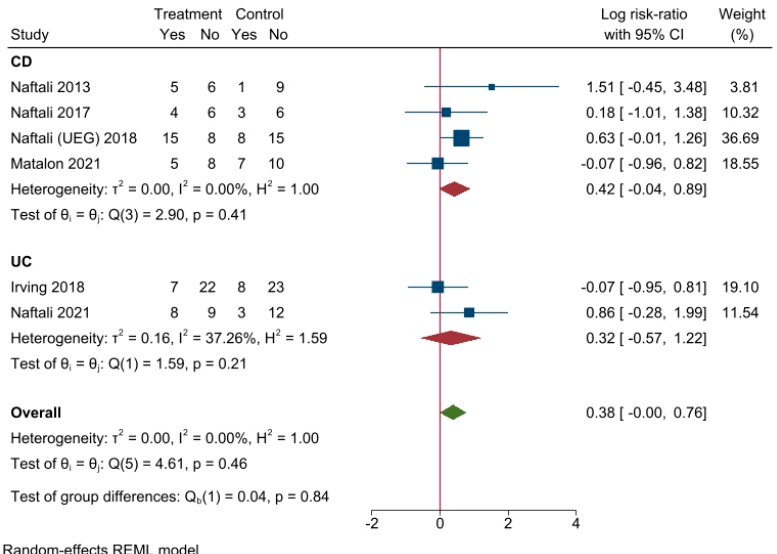
Figure 3. Forest plot of included studies. Values > 0 favors intervention, values < 0 favors control.